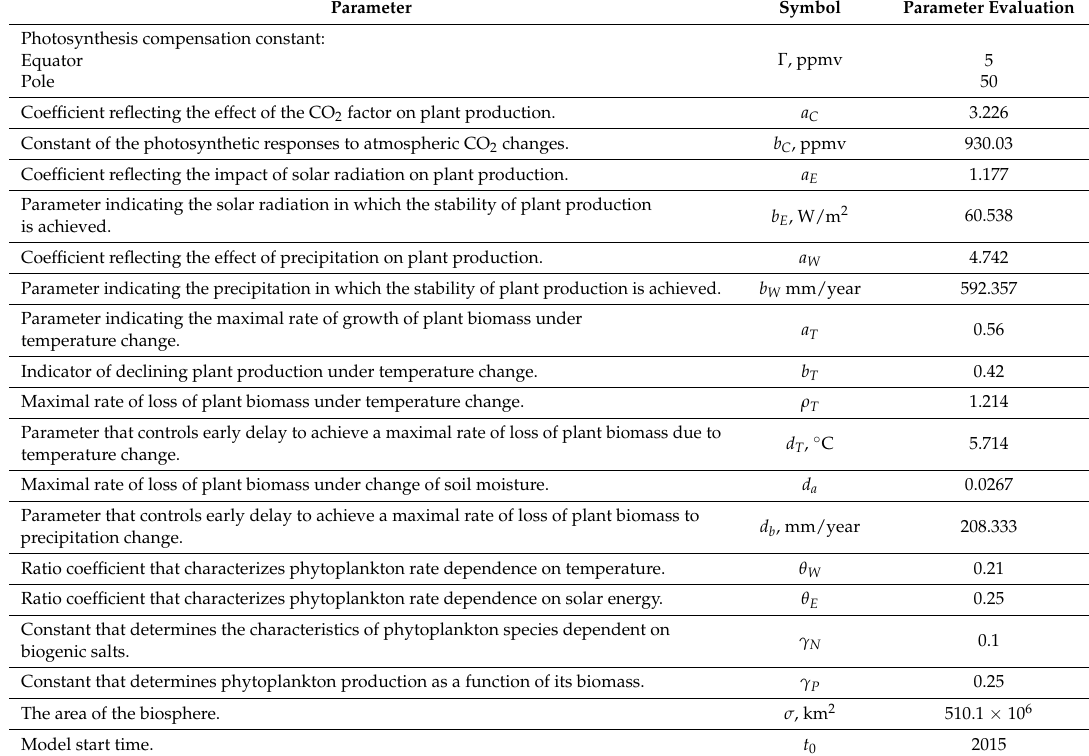
Table 2. List of the model